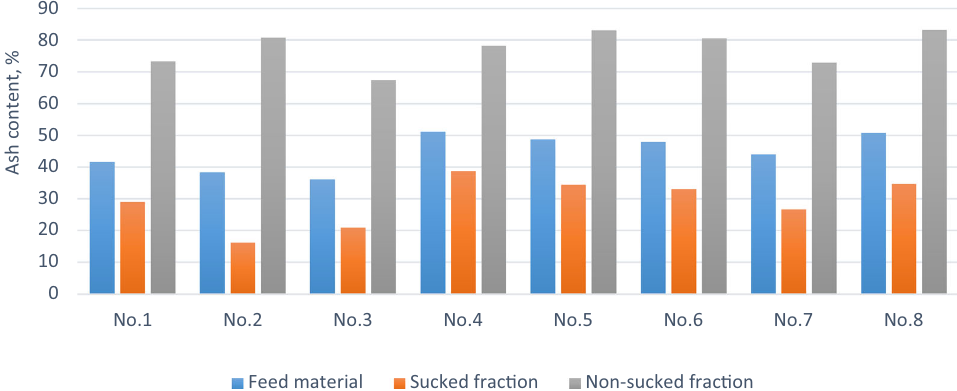
Fig. 16 Ash content with respect to the origin of the feed material (grain-size class of 20–50